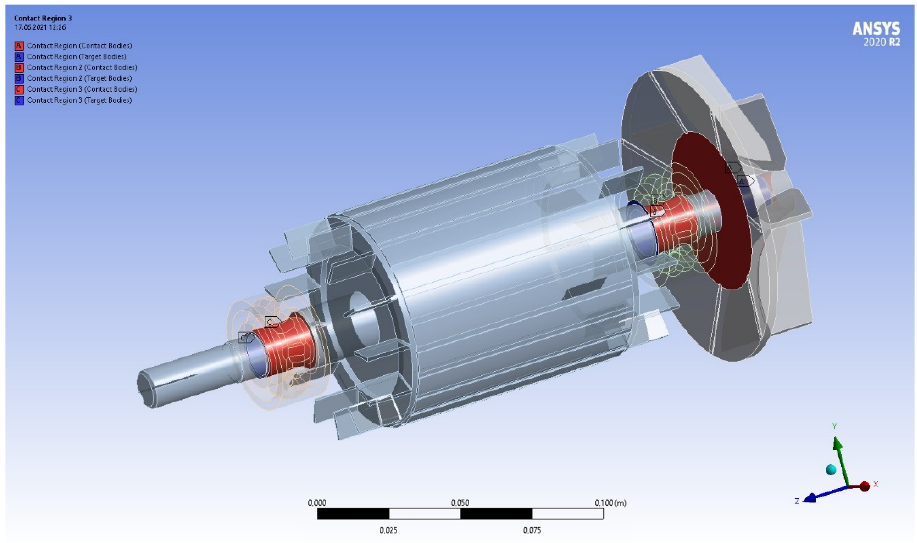
Figure 16. Assigning contact surfaces.